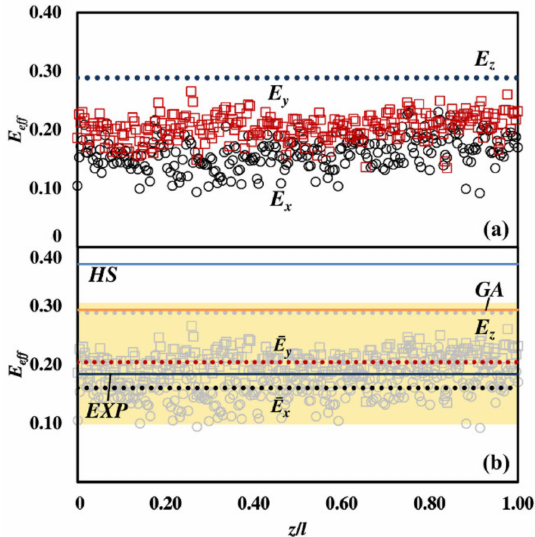
Figure 3. The NP relative effective longitudinal E z and transverse E x , E y Young’s moduli. ( a ) E z for the sample and E x (s), E y ( s ) in each section s . ( b ) E z and the average values E x and E y versus the Hashin-Shtrikman ( HS ) upper bound, the Gibson and Ashby (GA) and the exponential (EXP) estimates. The yellow region indicates literature data form [19] and Antonoiu [7] on different classes of NP Au and NP Pt samples with relative density φ from 0.5 to